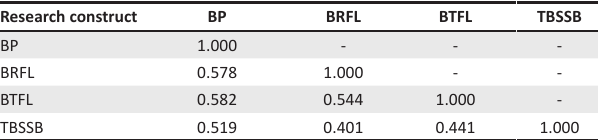
TABLE 3: Inter-construct correlation matrix. Research construct BP BRFL BTFL